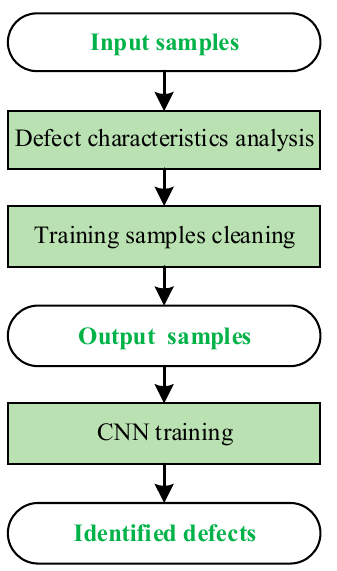
Figure 11. Flowchart of defect recognizing algorithm.